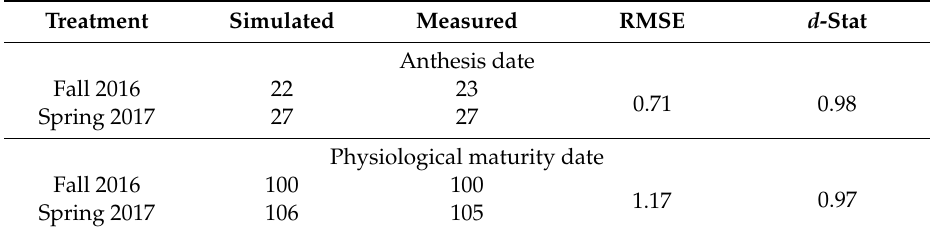
Table 3. Result of the model calibration for anthesis and maturity dates during the fall 2016 and spring 2017 seasons of drip irrigated fresh market tomato production in Immokalee, Florida.